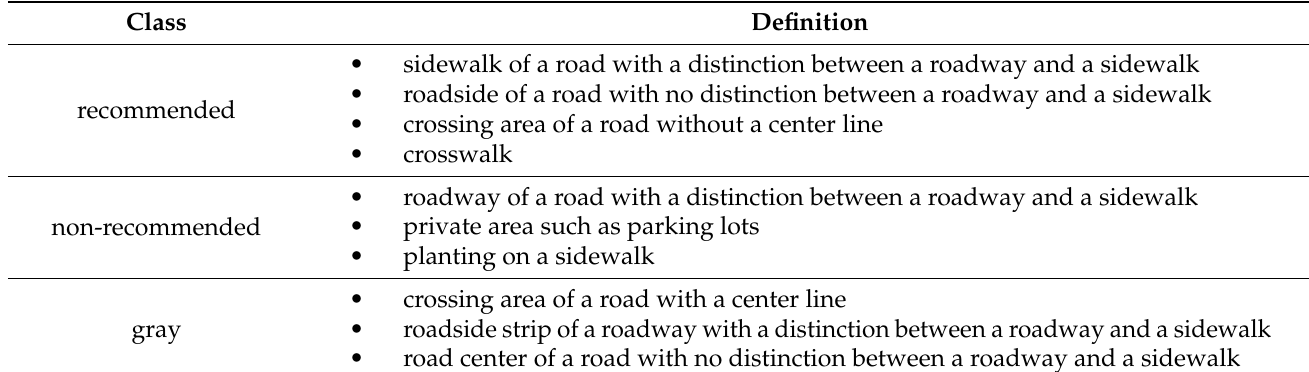
Table 3. Definition of manual labeling for evaluation dataset.